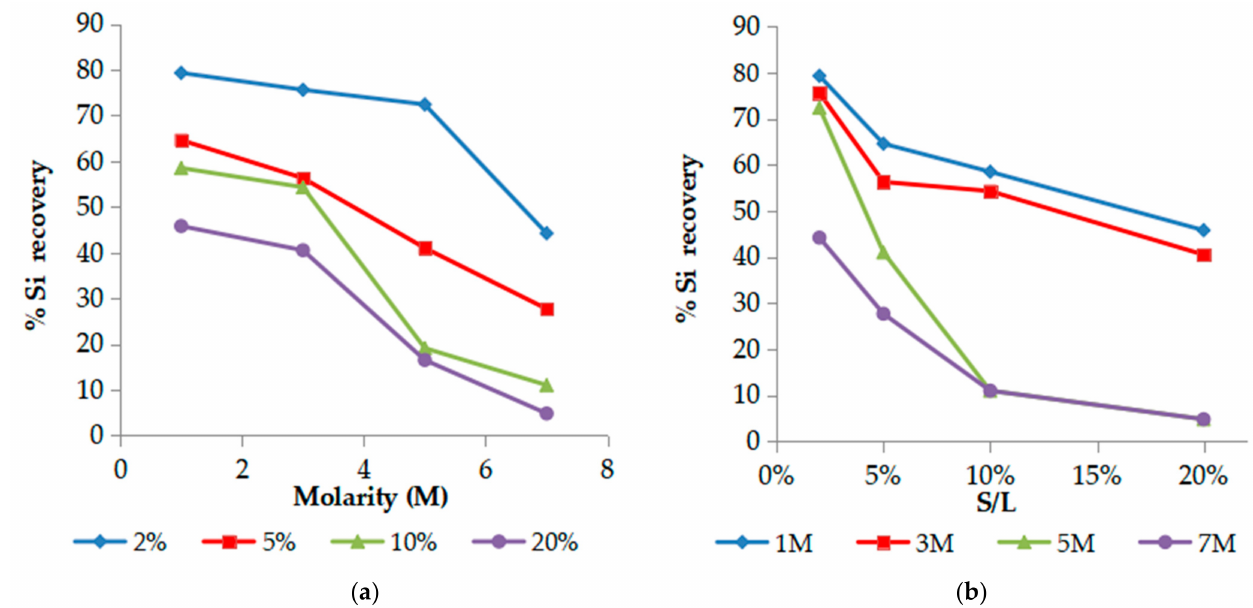
Figure 4. Effect of ( a ) acid molarity and ( b ) S/L ratio (pulp density) on % Si recovery. (T = 25 ◦ C, t = 60